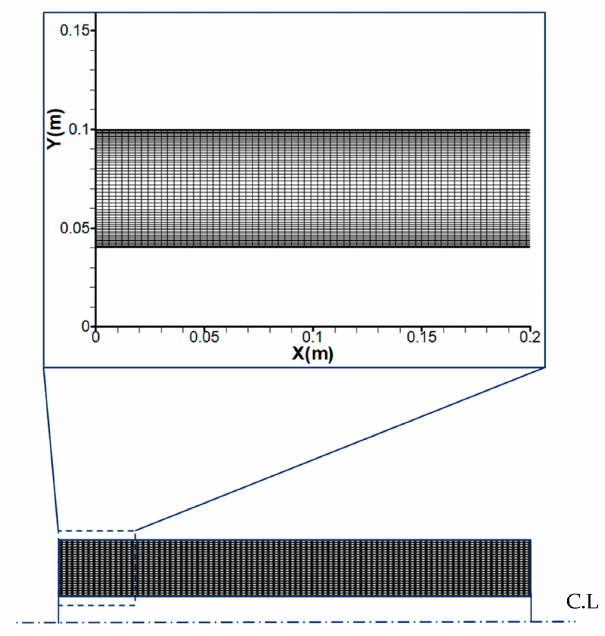
Table 4. Mesh independence for the present study considering different mesh sizes at 𝑅𝑒 = 500 . Mesh Size